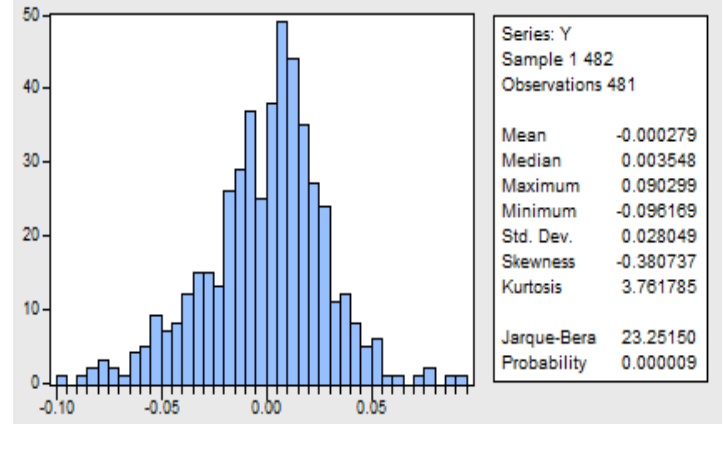
Table 1. ADF unit root test